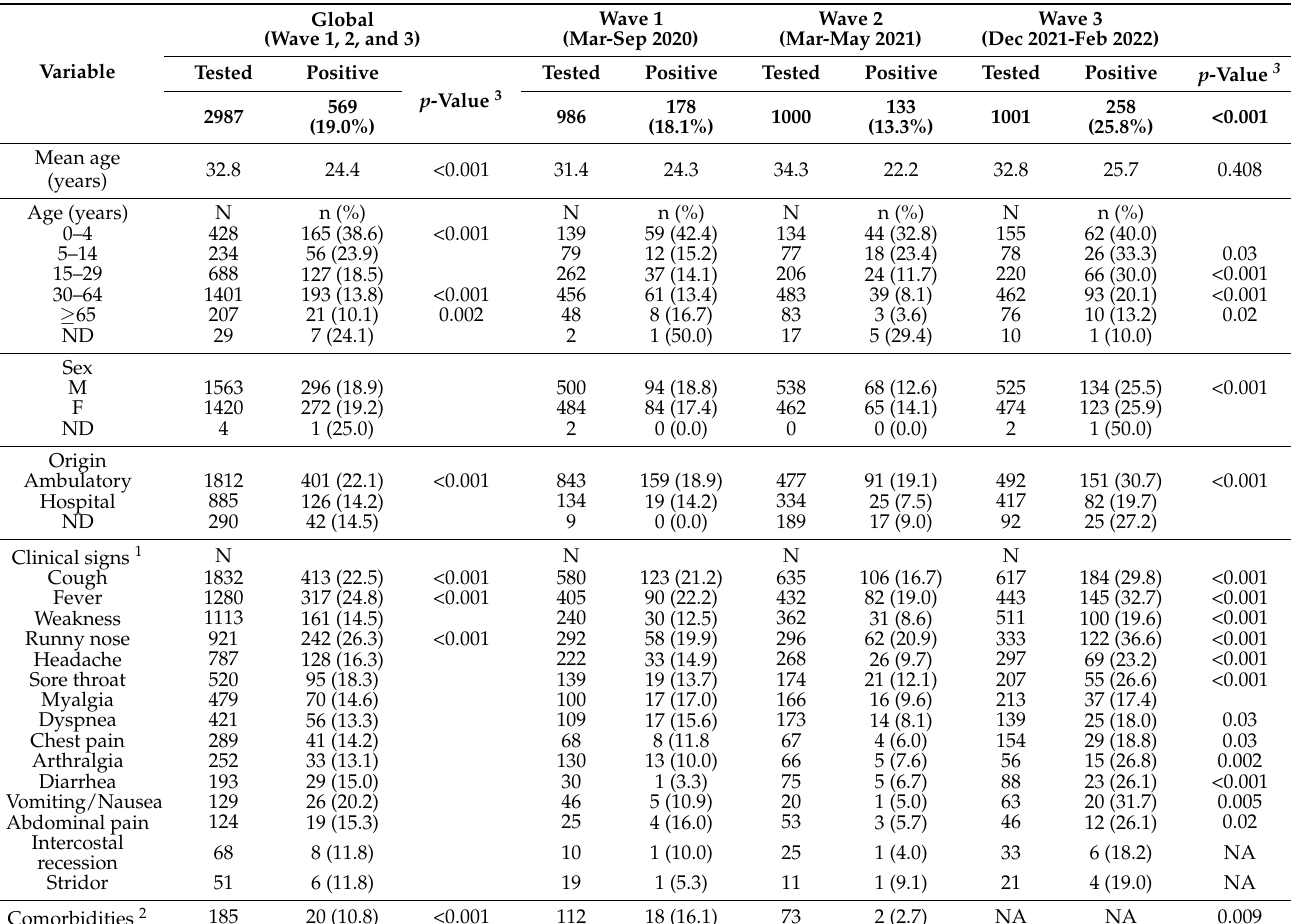
Table 1. Characteristics of COVID-19-negative patients who tested positive for seasonal